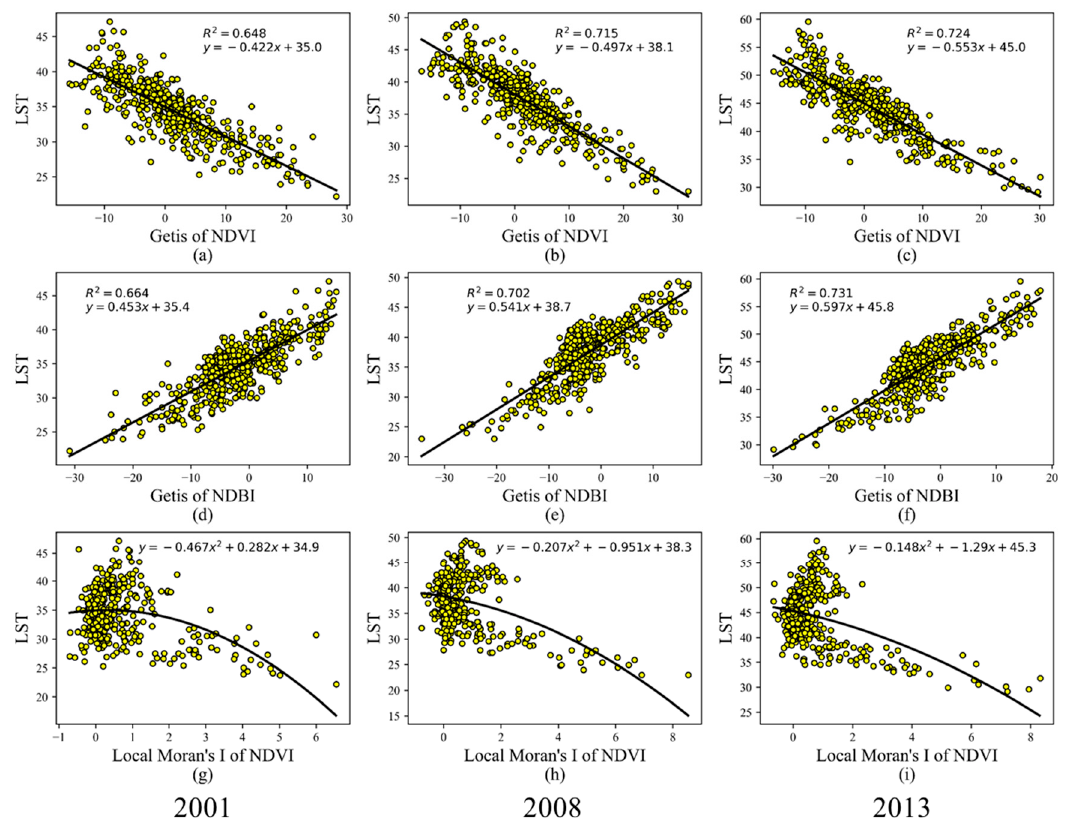
Figure 5. Scatterplots of LST with G of NDVI ( a – c ), G of NDBI ( d – f ), and local Moran’s I of NDVI ( g – i ) for 2001, 2008, and 2013.